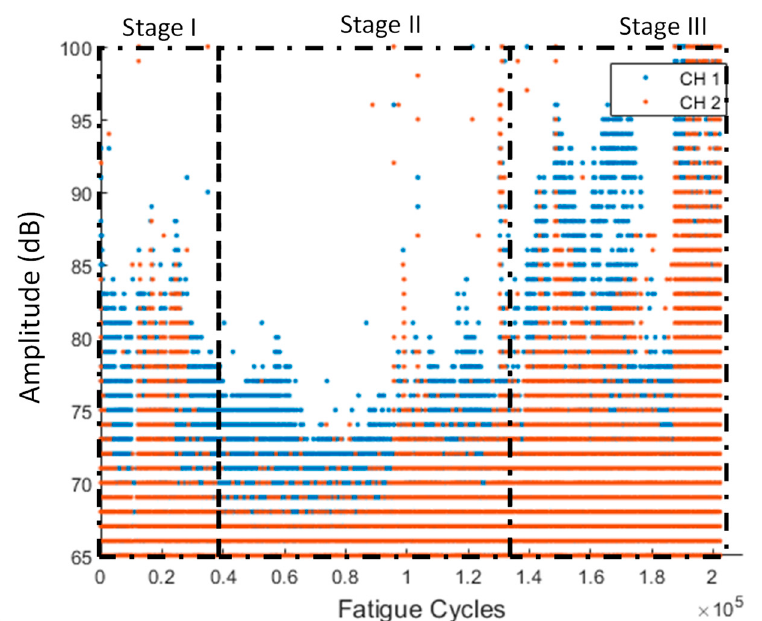
Figure 21. Amplitude vs. fatigue cycles for specimen VA-1 (stages I–III are qualitatively drawn).